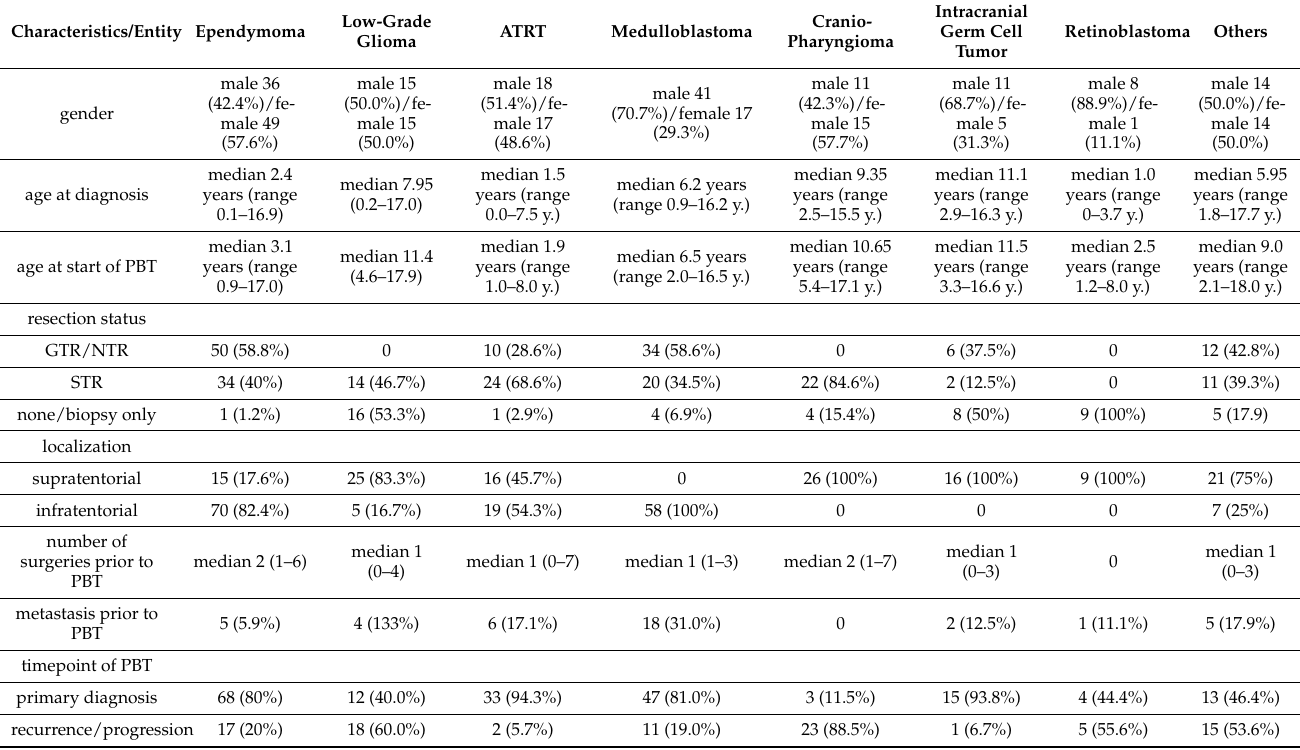
Table A2. Patient characteristics and treatment data of subgroup